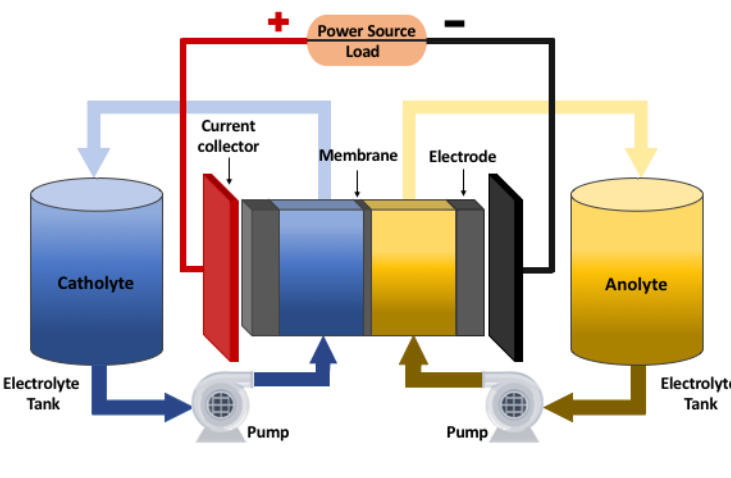
Figure 1. Scheme of a redox flow